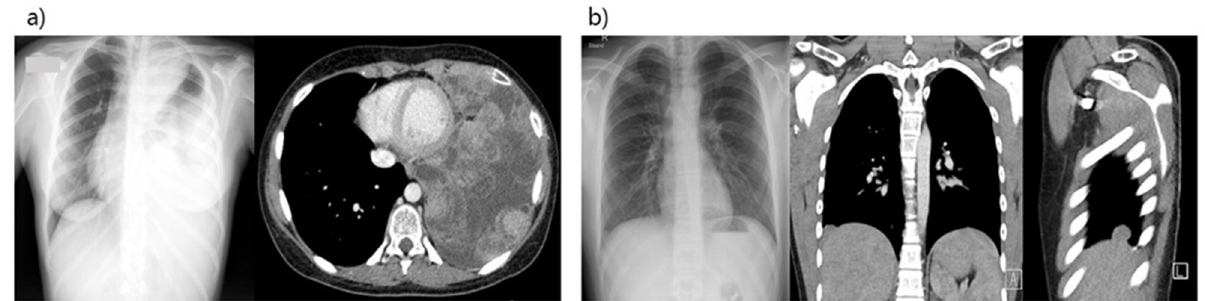
Figure 1. ( a ) Imaging of a patient with a pleuropulmonary localization of a primary localized Ewing sarcoma of the chest wall and ( b ) imaging of a patient with a pleural relapse in the left lateral sinus of an osteosarcoma.